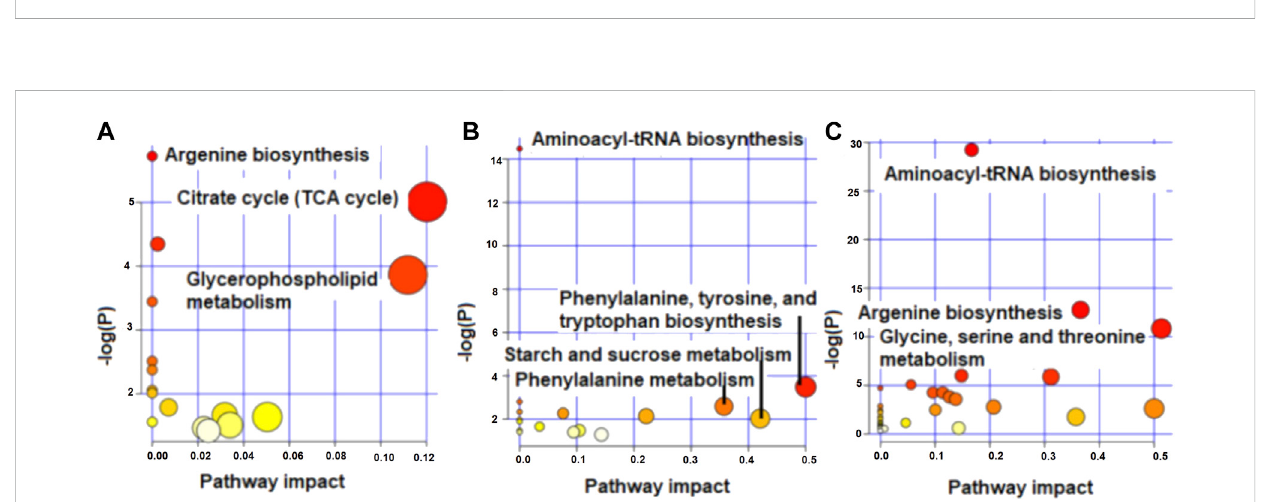
FIGURE 4 Metabolome view map showing enriched pathways for the metabolites that differed in concentration between high and low RFI groups at early (A) , mid (B) and late (C) stages of